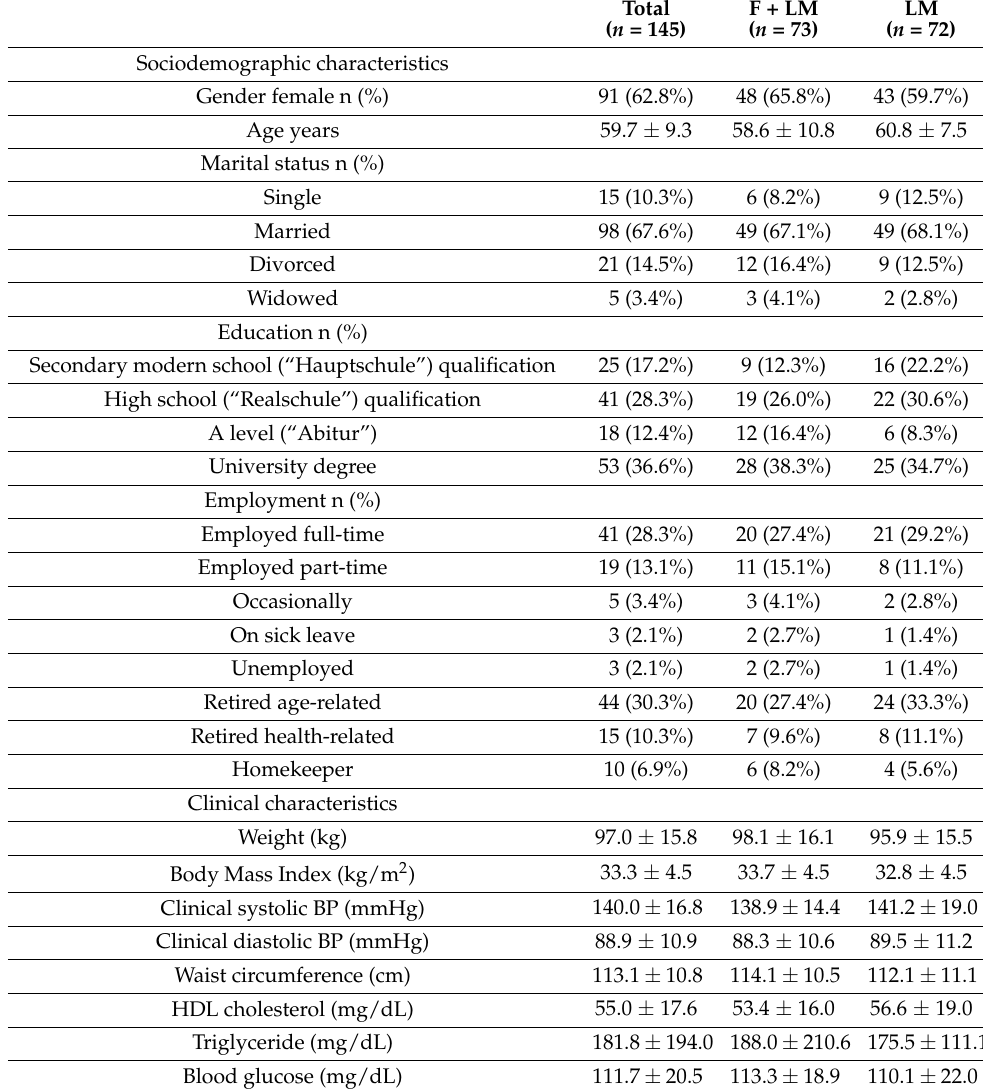
Table 1. Baseline sociodemographic and clinical characteristics. If not otherwise denoted, values are reported as mean ± standard